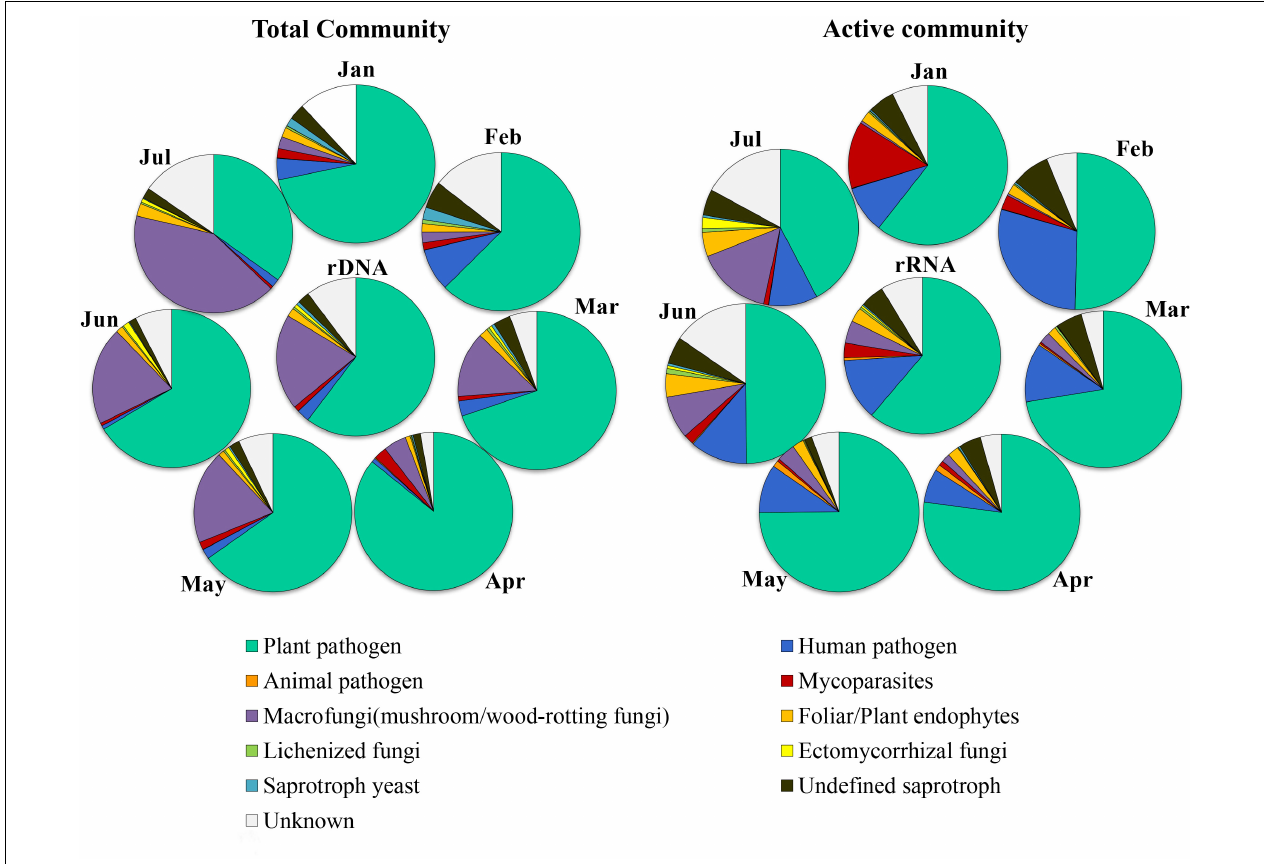
FIGURE 4 | Dynamics of relative abundance of major ecologically functional categories in different months in potential active fungal community (rRNA) and total fungal community (rDNA).